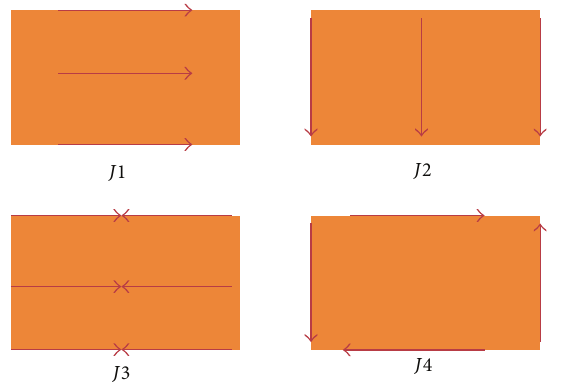
Figure 1: Characteristic modes of a ractangular plate.